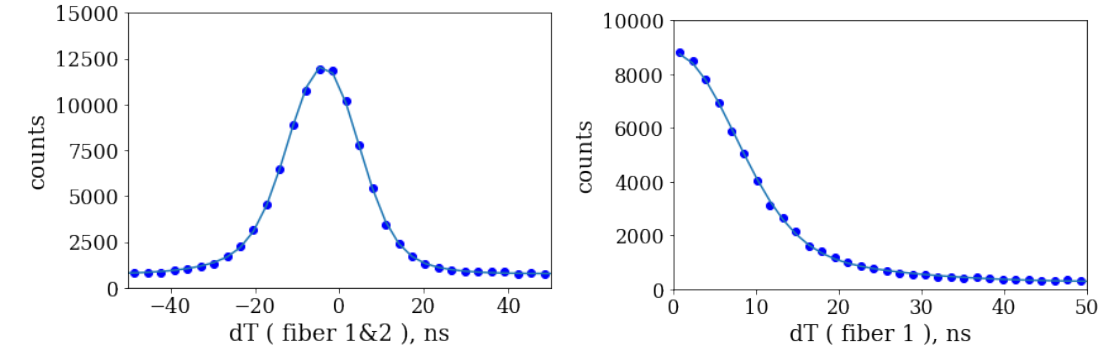
Figure 7. Left: distribution of measured time difference between photons registered in fiber 1 and fiber 2. Right: distribution of measured time difference between two photons in fiber 1. The distributions are fit with a double Gaussian function and a constant, see the text for